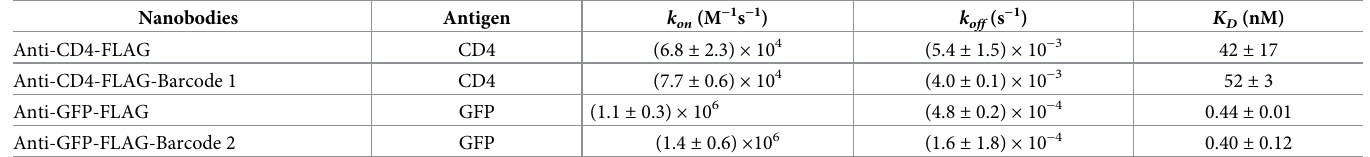
Table 1. Kinetic parameters of the nanobodies measured by surface plasmon resonance. Each value represents the mean ± standard deviation of three technical replicates. Nanobodies